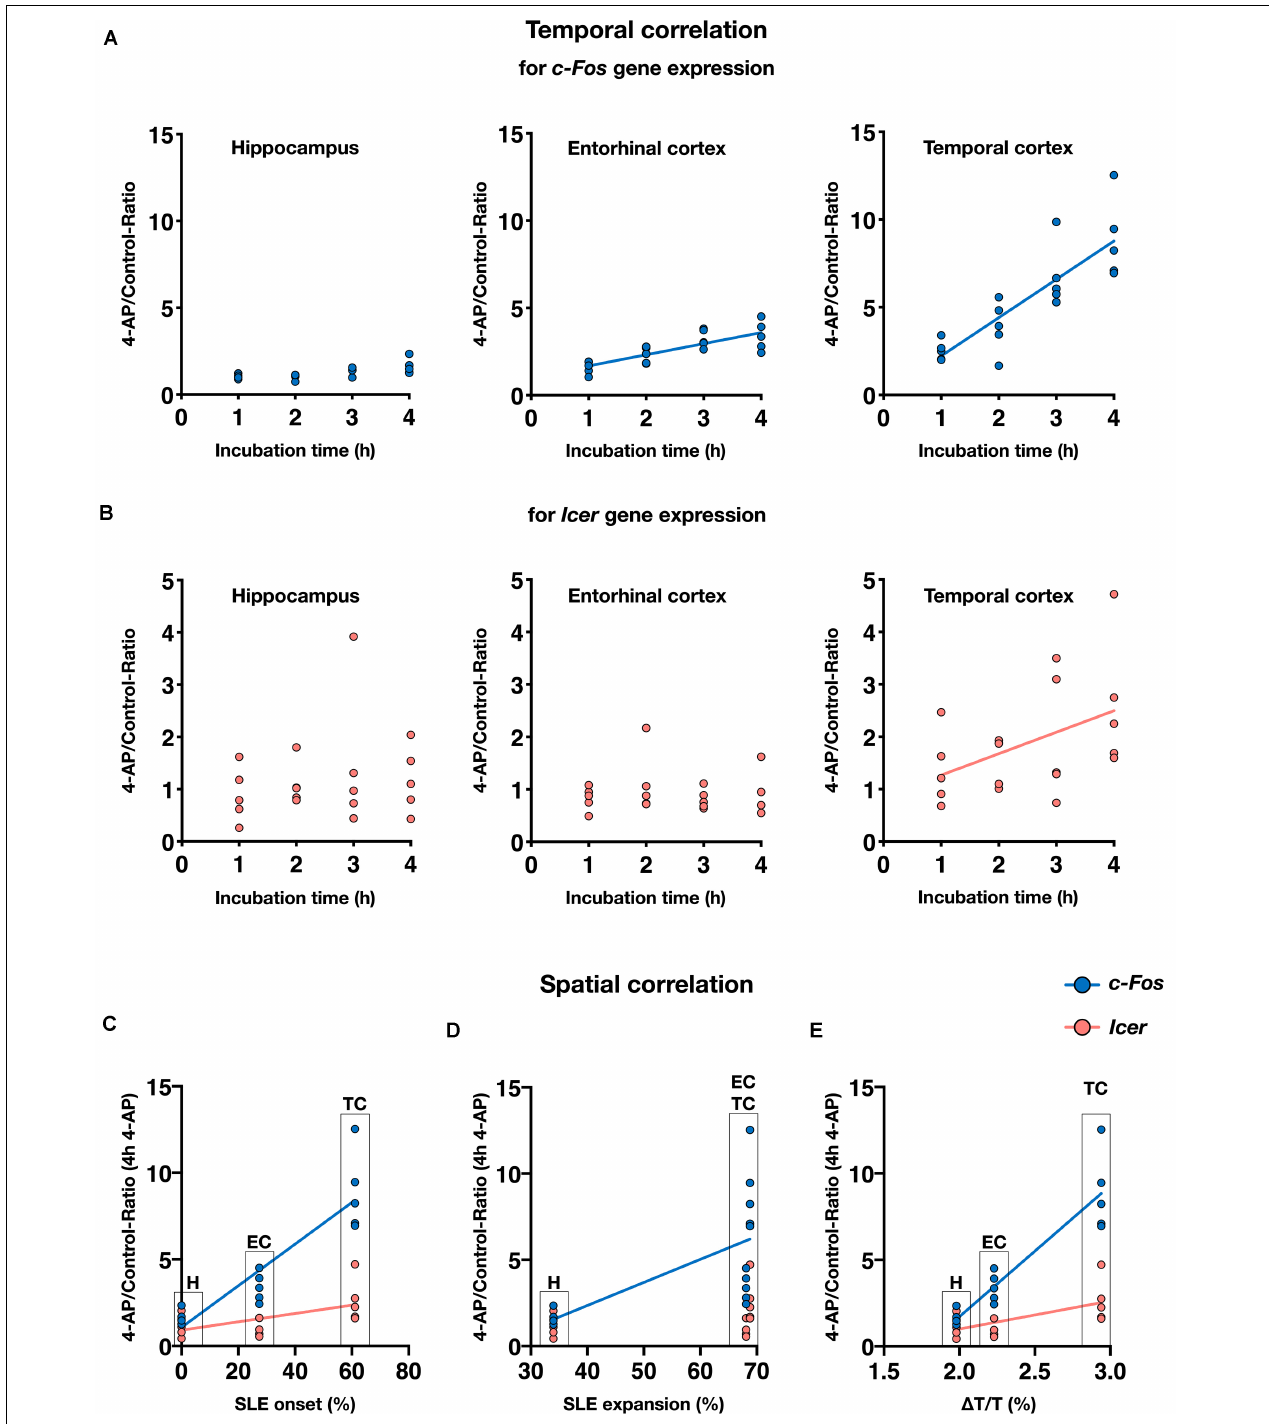
FIGURE 6 | Spatiotemporal correlation of epileptiform activity and gene expression in rat slices. Summary of results from rat slices demonstrating spatial and temporal dependence of c-Fos and Icer expression. (A,B) Scatter plots show means of mRNA expression ratios of 4-AP vs. control from individual rats ( n = 20) and different incubation intervals for hippocampus (H), entorhinal cortex (EC), and temporal cortex (TC), respectively. Regression lines show significant temporal correlation between 4-AP exposure and c-Fos (A) or Icer expression (B) . (C–E) Spatial dependence of gene expression following 4-AP treatment duration of 4 h ( n = 5) shown by spatial parameters such as rate of SLE onset (C) , SLE expansion within anatomical region (D) as well as SLE amplitude (E) . Note that data in C-E are presented as median and do not sum up to 100%.